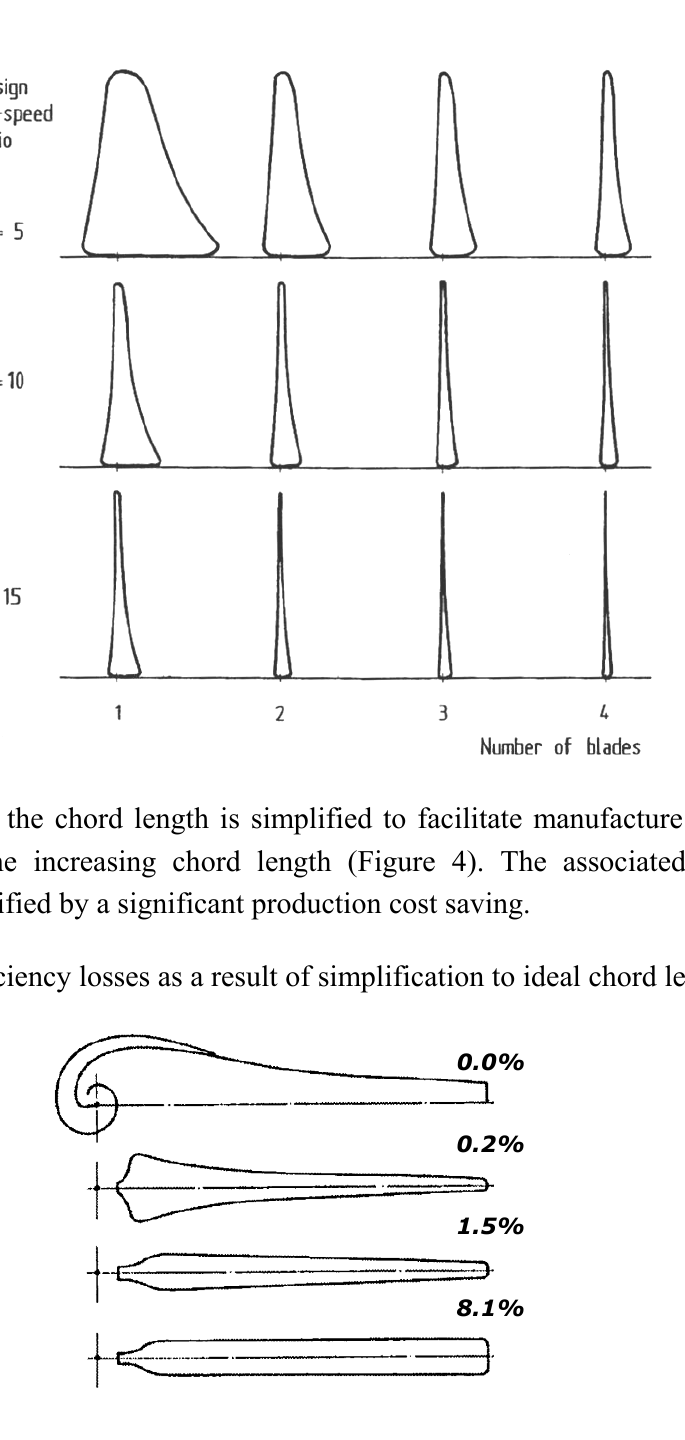
Figure 3. Optimal blade plan shape for alternate design tip speed ratios and number of blades [1].